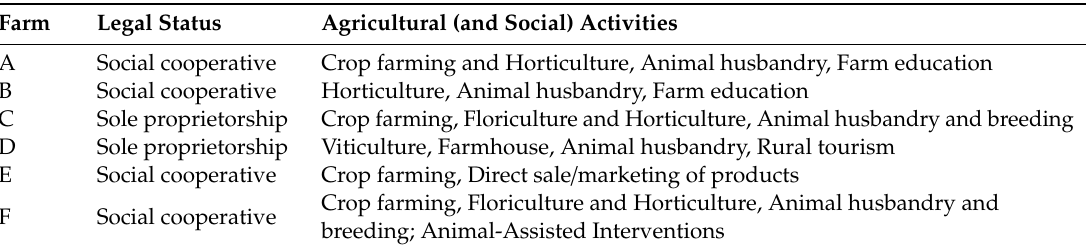
Table 1. Characteristics of the participating